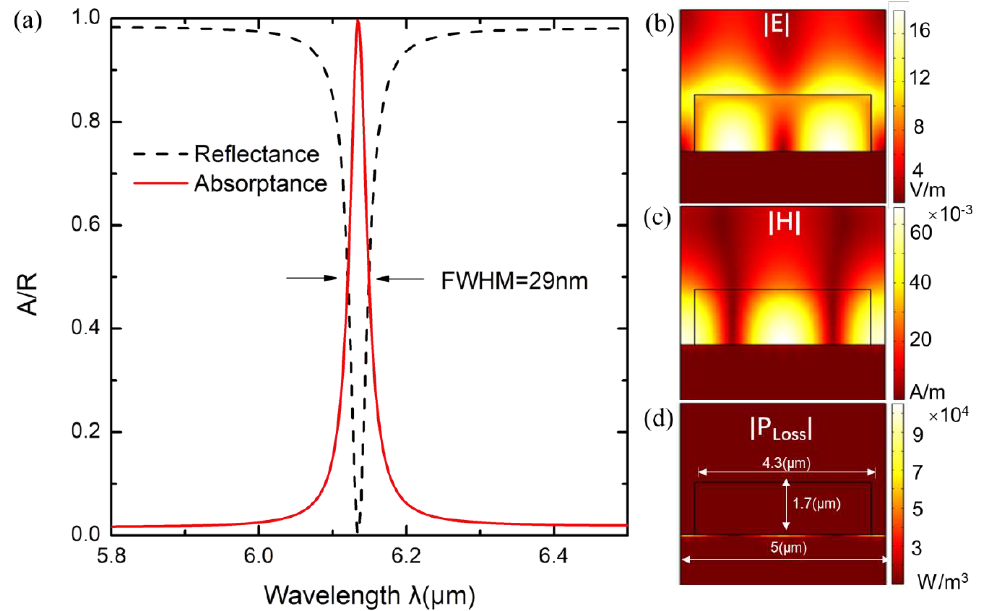
Figure 2. ( a ) Absorption and reflection spectra of the absorber. The parameters of the dielectric grating strips are P = 5 μm, W = 4.3 μm, H = 1.7 μm; ( b ) Electric field distribution; ( c ) Magnetic field distribution; and, ( d ) Power loss distribution of the absorber at resonant wavelength of 6.134 μm.